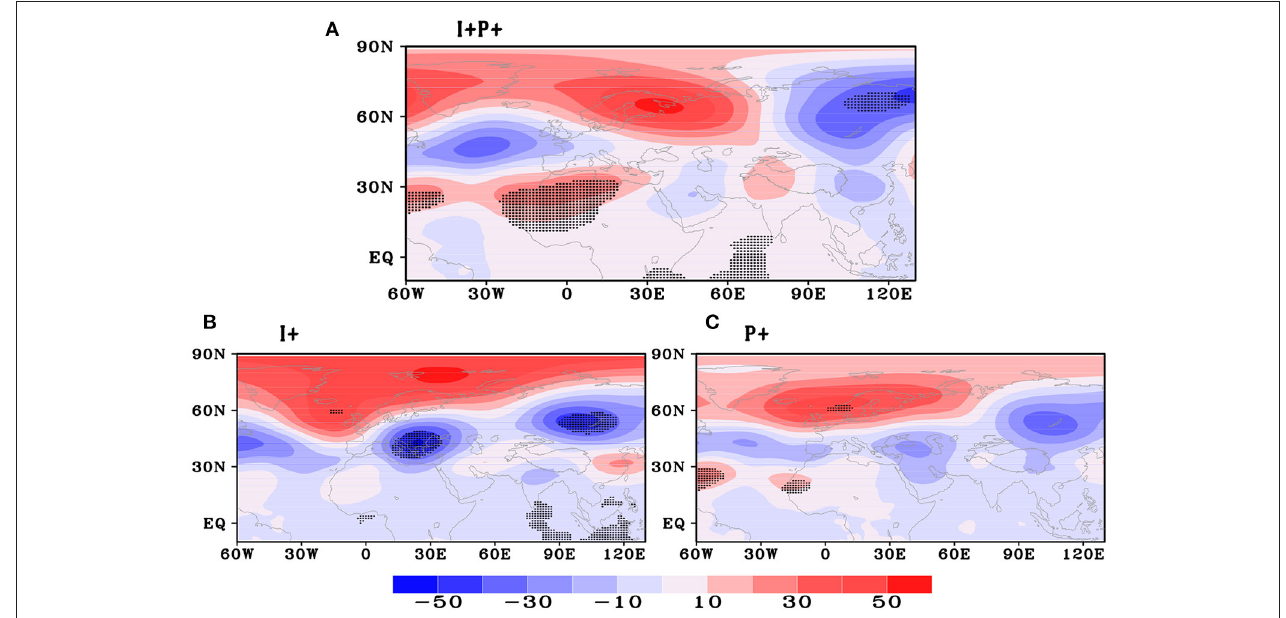
FIGURE 8 | A 200-hPa geopotential height anomaly (gpm) of the CAM5 simulation experiments forced by (A) positive IOD and ENSO simultaneously, (B) individual positive IOD, and (C) individual El Niño, respectively. Black dots indicate that the values exceeding the 95% confidence level.